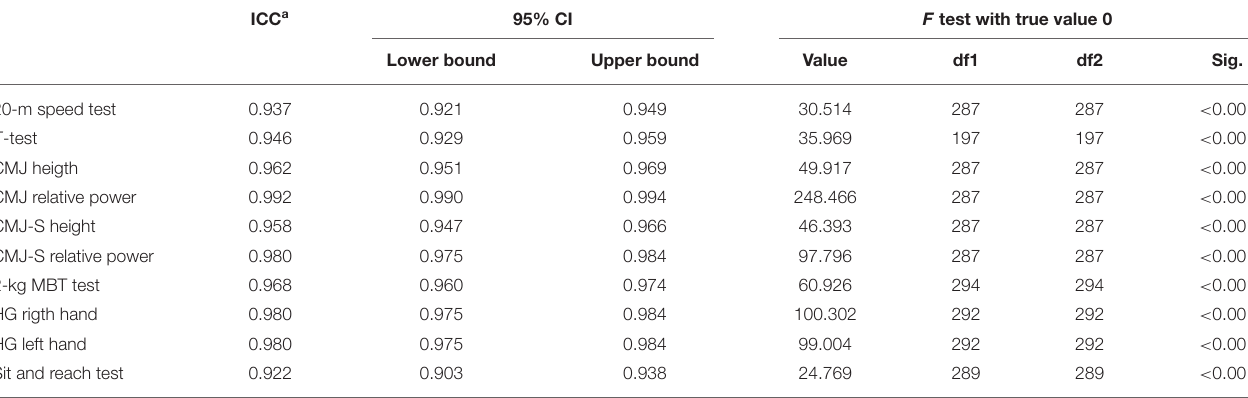
TABLE 1 | Intraclass correlation statistics for inter-rater reliability for the physical tests. ICC a 95% CI F test with true value 0 Lower bound Upper bound Value df1 df2 Sig.